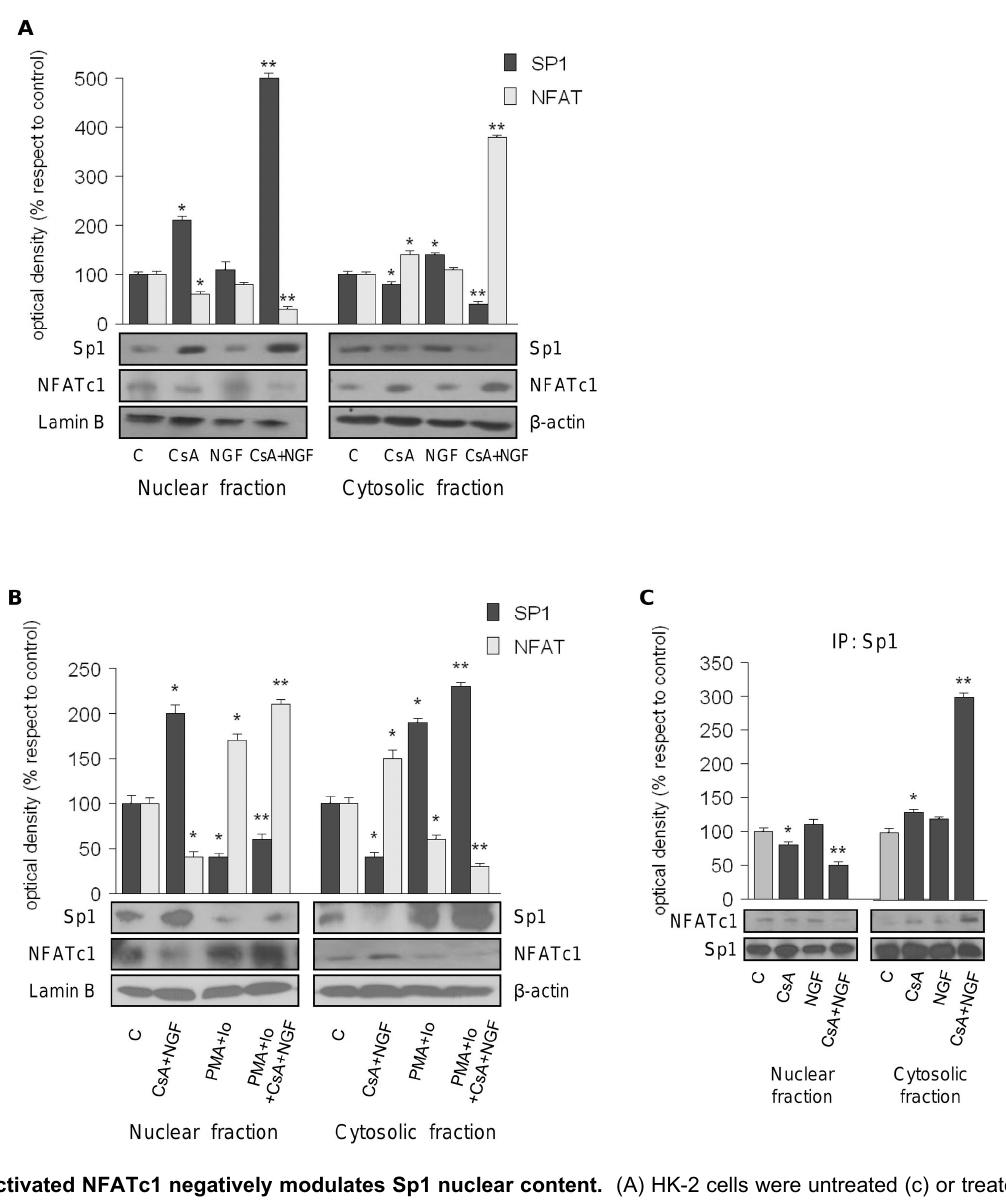
Figure 3. Activated NFATc1 negatively modulates Sp1 nuclear content. (A) HK-2 cells were untreated (c) or treated with CsA 10nM, NGF 100ng/ml alone or in combination for 15h before lysis. Nuclear and cytosolic expression of NFATc1 (Antibody dilution 1:100) and Sp1 (1:1000) were evaluated. Lamin B (1:10000) and β-Actin (1:10000) were used respectively as nuclear and cytosolic loading controls. The upper panels represent the means ± SD of 3 separate experiments between Sp1/Lamin B or Sp1/β-Actin and NFATc1/Lamin B or NFATc1/β-Actin levels in which band intensities were evaluated as optical density arbitrary units and expressed as percentages of the control (100%). *p<0.05 compared with c; **p<0.05 compared with cells treated with CsA alone (B) NFATc1 and Sp1 nuclear and cytosolic protein content of HK-2 cells untreated (c) or treated for 15 h with CsA 10nM+NGF 100ng/ml, PMA 100nM+Io 2.5μM, PMA+Io+CsA+NGF. The upper panels represent the means ± SD of 3 separate experiments between Sp1/Lamin B or Sp1/β-Actin and NFATc1/Lamin B or NFATc1/β-Actin levels in which band intensities were evaluated as optical density arbitrary units and expressed as percentages of the control (100%). *p<0.05 vs untreated cells. (C) HK-2 cells were untreated (c) or treated with CsA 10nM, NGF 100ng/ml alone or in combination for 24h. Total cell lysates were immunoprecipitated with anti-Sp1 antibody (IP:Sp1) and then subjected to immunoblot analyses with anti-NFATc1 and anti-Sp1 antibodies. The upper panels represent the means ± SD of 3 separate experiments between NFATc1/Sp1 levels in which band intensities were evaluated as optical density arbitrary units and expressed as percentages of the control (100%). *p<0.05 vs untreated cells; **p<0.05 vs cells CsA +NGF-treated. All immunoblots show a single representative of 3 separate experiments. Secondary antibodies dilutions used are: goat anti-mouse (1:2000) or anti-rabbit (1:7000) or donkey anti-goat (1:3000) IgG. doi: 10.1371/journal.pone.0080113.g003 PLOS ONE |